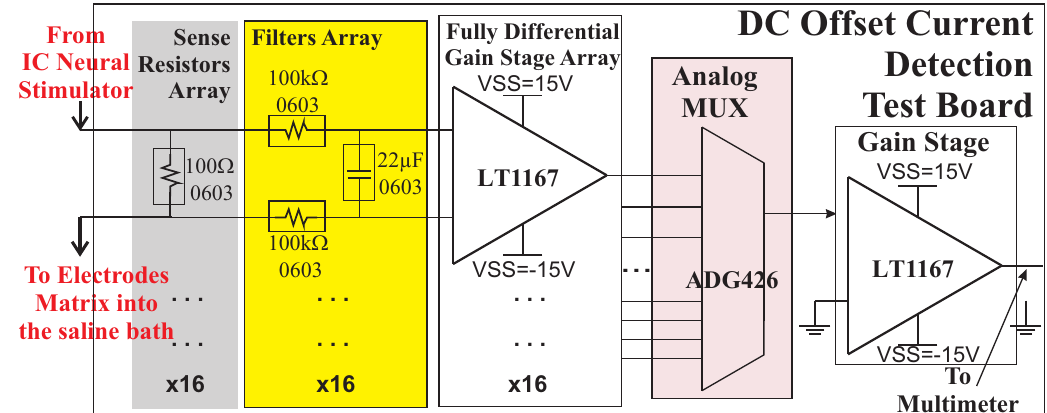
Figure 4. Sketch of the DC offset current detection test board.